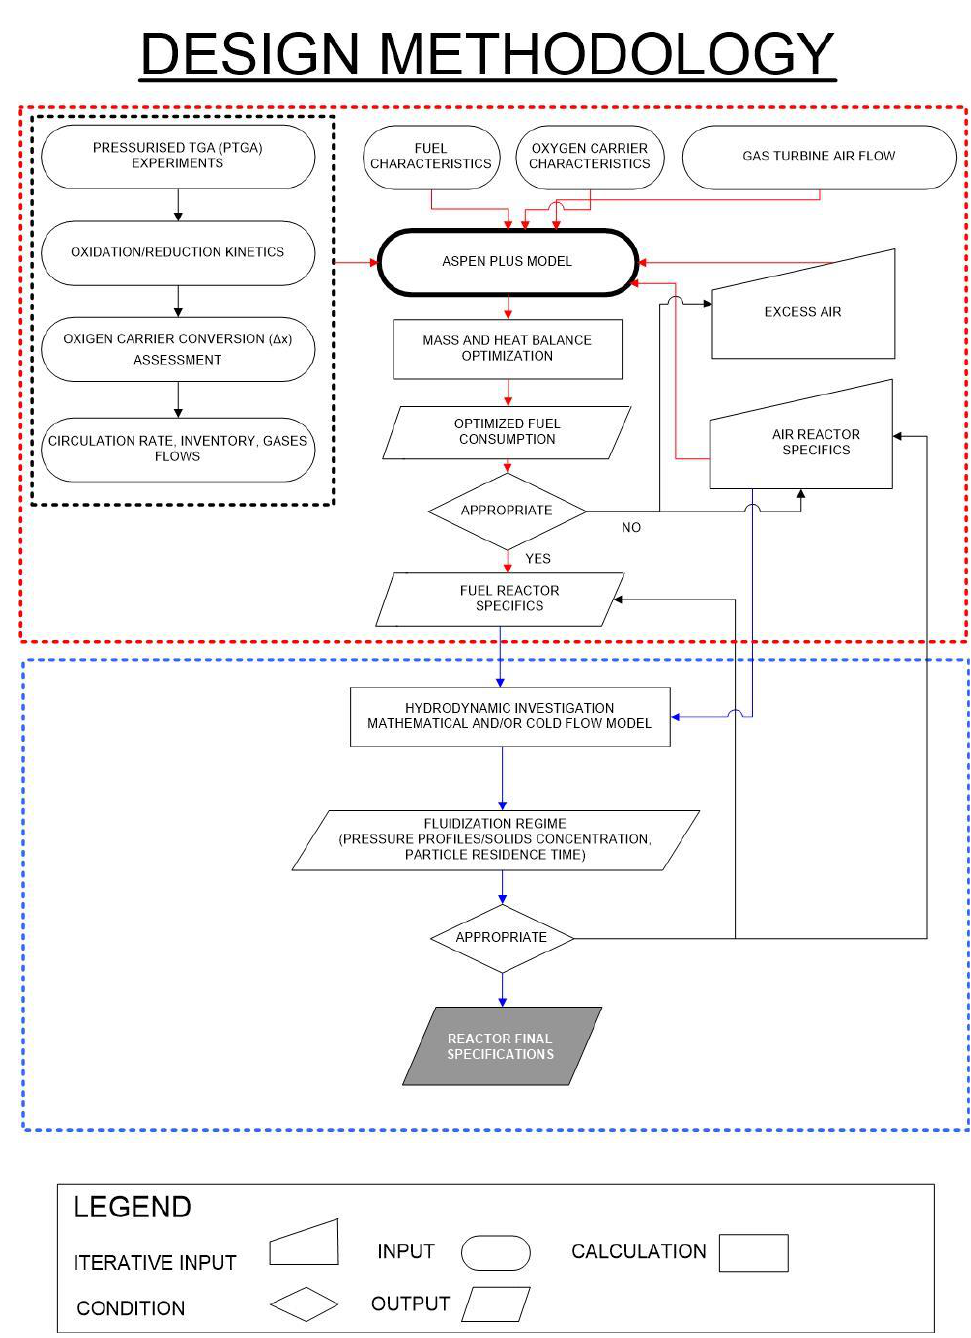
Figure 3. Design procedure for a power plant using a pressurized chemical looping combustor coupled with a turbo expander, adapted with permission from [21].